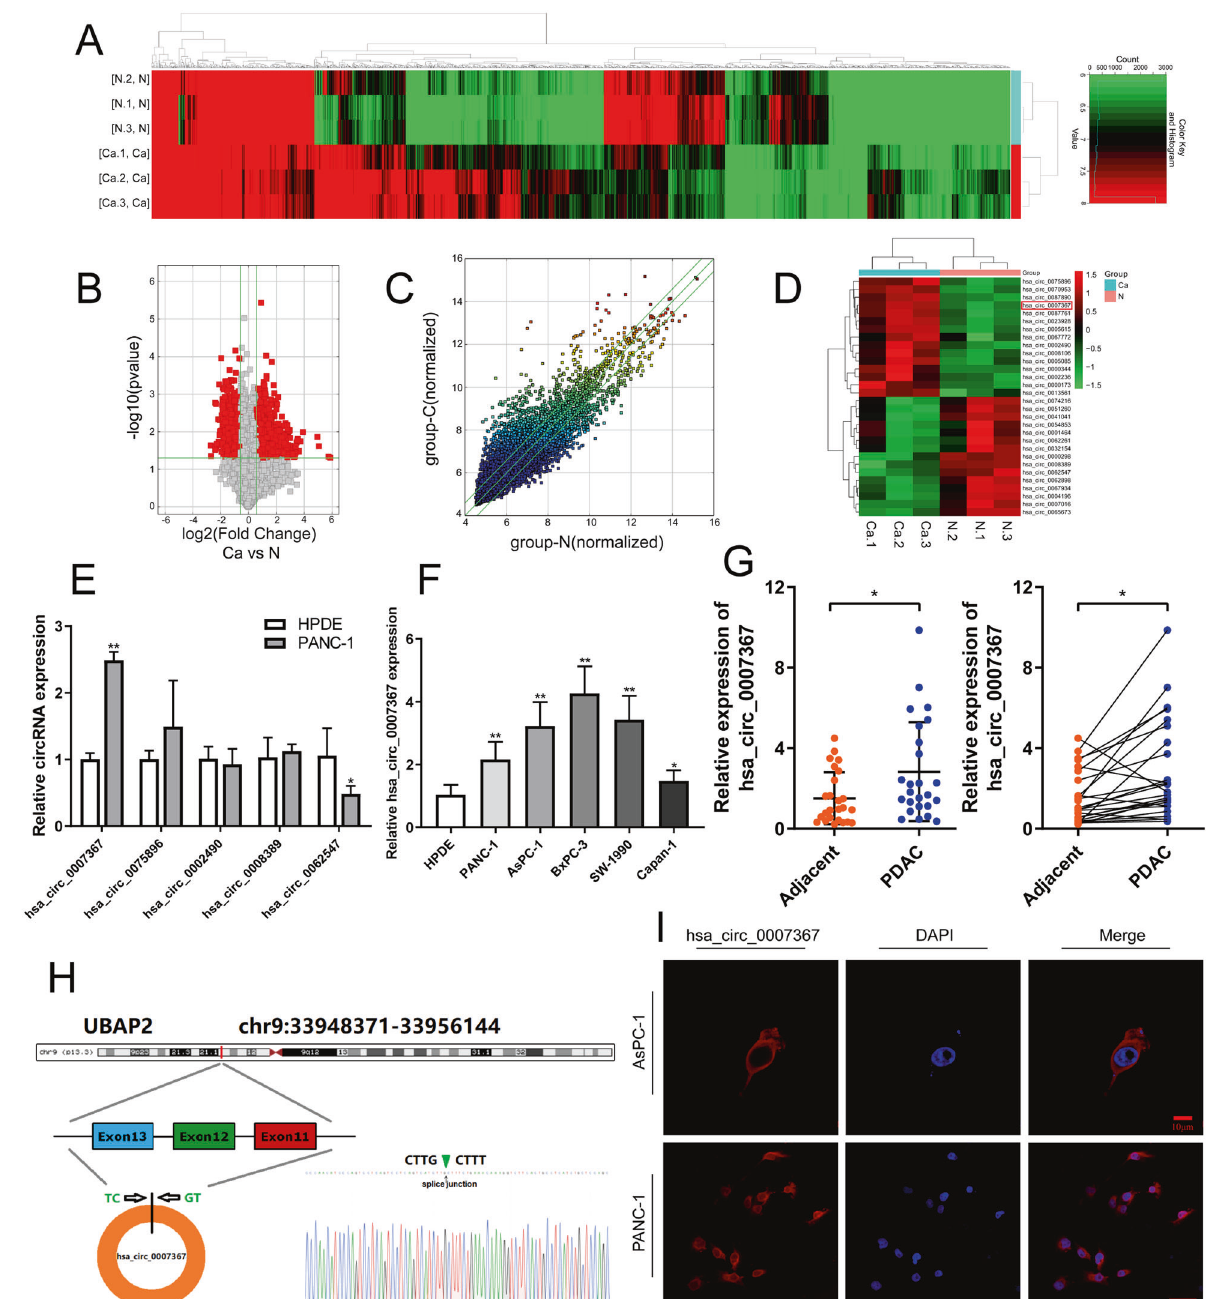
Fig. 1 Identi fi cation and characterization of hsa_circ_0007367 in PDAC. A Hierarchical clustering of differentially expressed circRNAs in 3 pairs of PDAC and their matched normal tissues. Red represents upregulated circRNAs, and green represents downregulated circRNAs. B Volcano plot of differentially expressed circRNAs, the − log10 ( p -value) and the log2 (fold change) are plotted on the y and x axes, respectively. The red dots represent the differentially expressed circRNAs with statistical signi fi cance. C The scatter plot shows the dysregulated circRNAs in PDAC tissues compared with matched normal pancreas tissues. The space above the top green line and below the bottom green line indicated more than 1.5-fold change. D The heatmap for 15 differentially up- and downregulated circRNAs. E qRT-PCR analysis of the fi ve dysregulated circRNAs in PANC-1 cells compared to HPDE cells (the normal pancreatic cell line). F , G qRT-PCR for the expression of hsa_circ_0007367 in PDAC cell lines and tissues. H Schematic illustration of the genomic location and splicing pattern of hsa_circ_0007367, with the splicing site identi fi ed by Sanger sequencing. I FISH assay showed the subcellular localization of hsa_circ_0007367 in PDAC cells. All data are shown as the mean ± SD of at least three independent experiments. * p < 0.05, ** p < 0.01. were constructed in HEK293T cells (Fig. 4C). The results indicated Accordingly, a dual-luciferase reporter assay was performed to that transfection of miR-6820-3p mimics markedly suppressed the identify the speci fi c binding site between hsa_circ_0007367 and luciferase activity of the wild-type reporter, whereas mutant miR-6820-3p. Luciferase reporter plasmids containing wild or construct showed no signi fi cant effect (Fig. 4D). However, in mutated hsa_circ_0007367 with the miR-6820-3p binding site